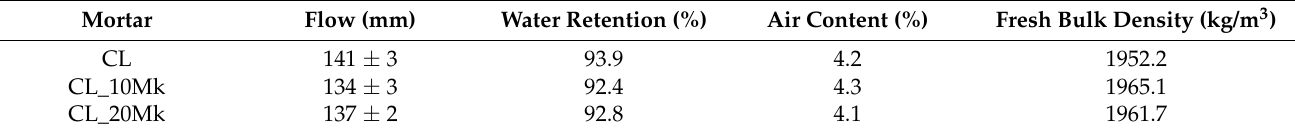
Table 4. Flow table consistency, water retention, air content, and bulk density of fresh mortars.